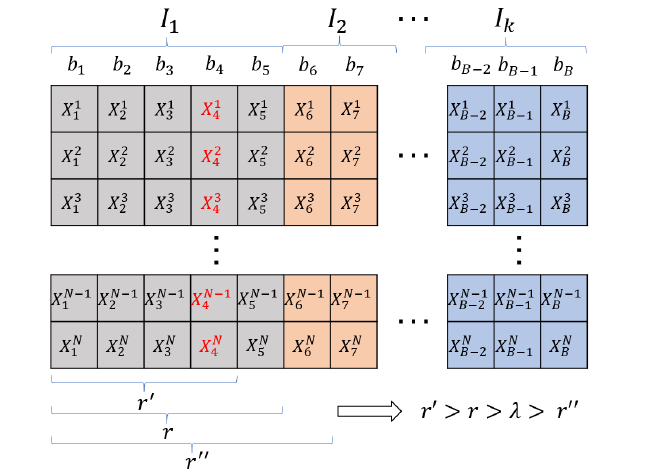
Figure 2. Schematic of the partitioning